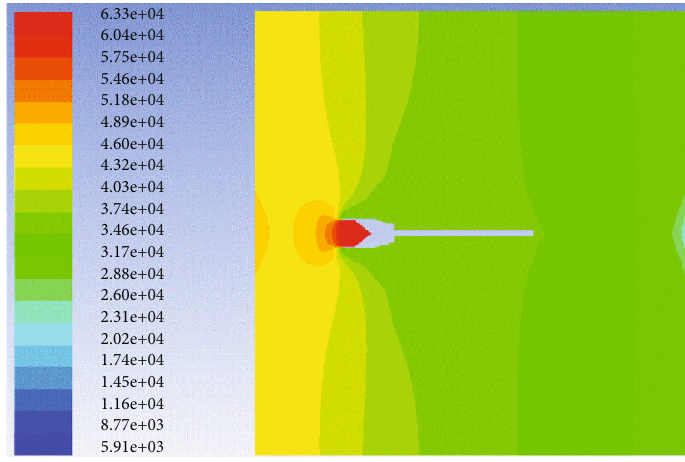
Figure 9: Pressure contour when v = 30 m / s , α = 0 ∘ .